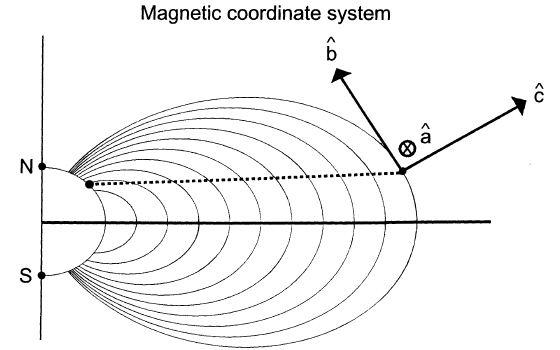
Fig. 2. Magnetic coordinate system used to identify in situ directions: ^ b is a unit vector in the magnetic-field direction; ^ a is a unit vector in the magnetic zonal direction; and ^ c is a unit vector in the magnetic meridian, orthogonal to ^ a and ^ b with the westward component of the line of sight (see Fig. 5 for the definition of the angle (cid:110) ). For every plane- wave event modeled (in the JE93 event pool), we projected the (cid:135)^ a direction from L (cid:136) 2 : 2 along that instantaneous line of sight onto the VLA plane, the